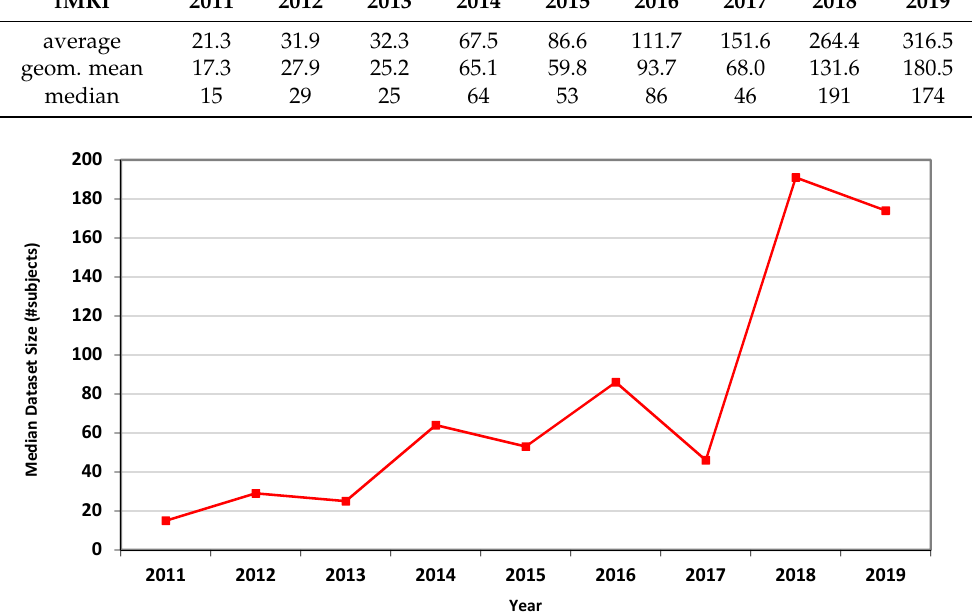
Figure 3. Median size of datasets used in MICCAI articles related to fMRI in each of the years 2011– 2019.